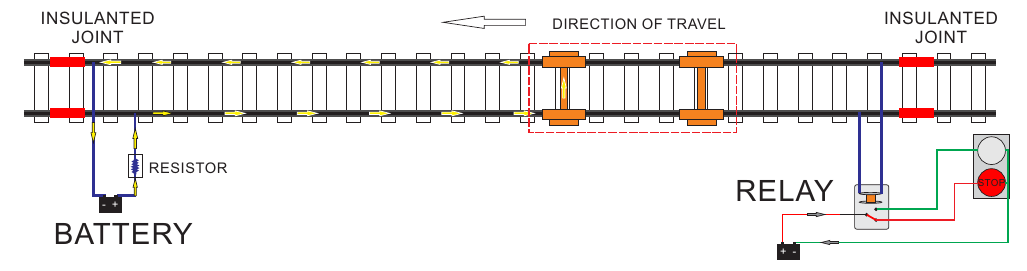
Figure 2. Example of a DC track circuit occupied by a train.